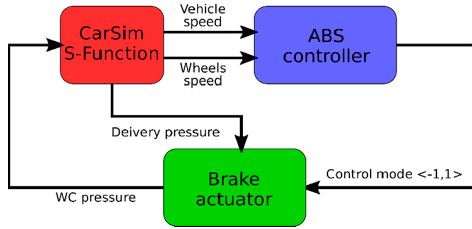
Figure 4. Block scheme of ABS control